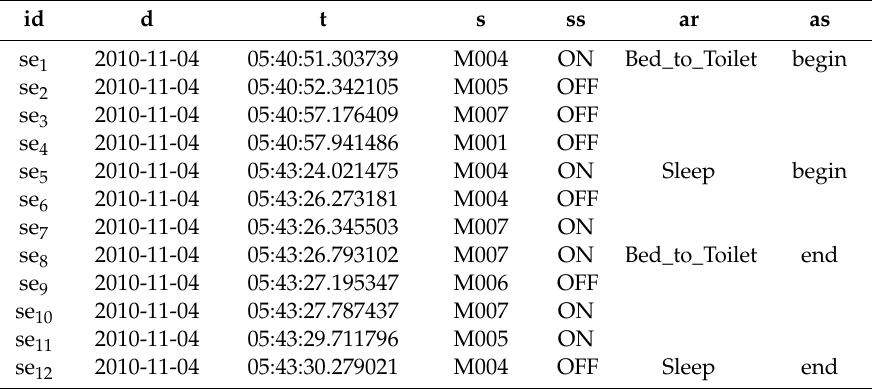
Table 1. A segment of activity